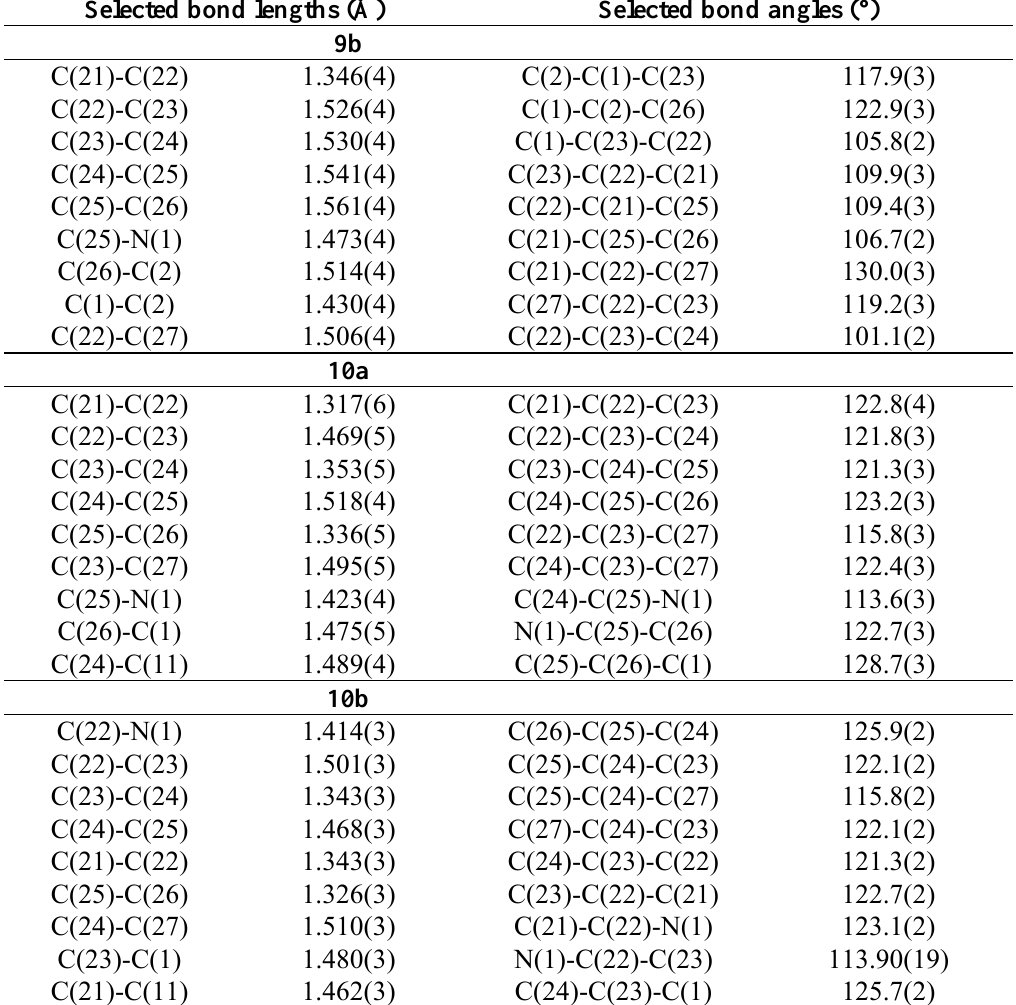
Table 1. Selected bond lengths and bond angles for 9b , 10a and 10b